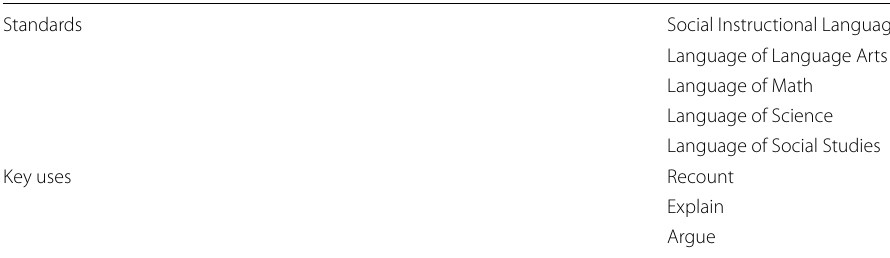
Table 1 Attributes in the standards-based Q -matrix